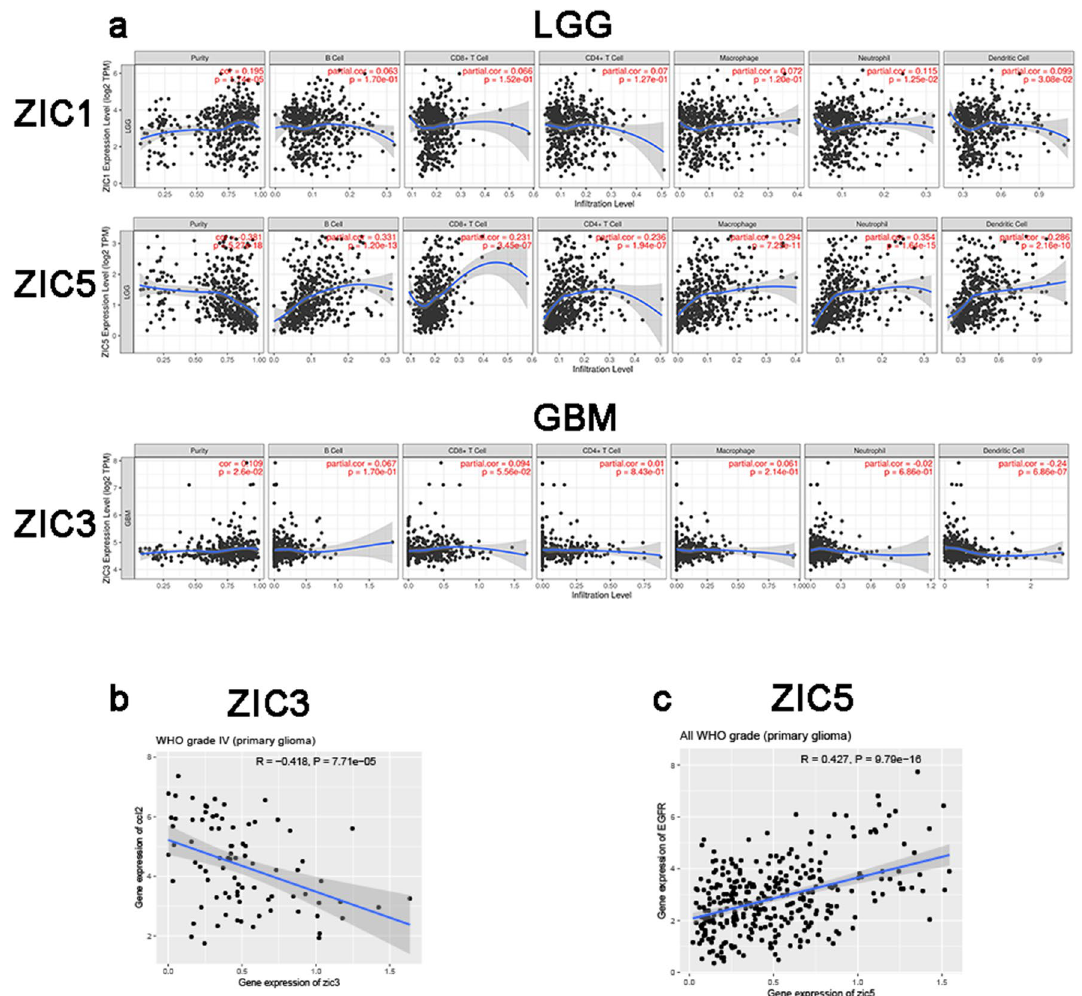
Figure 5. The association between differentially expressed ZICs and immune cell infiltration in gliomas samples ( A , B ) (TIMER).